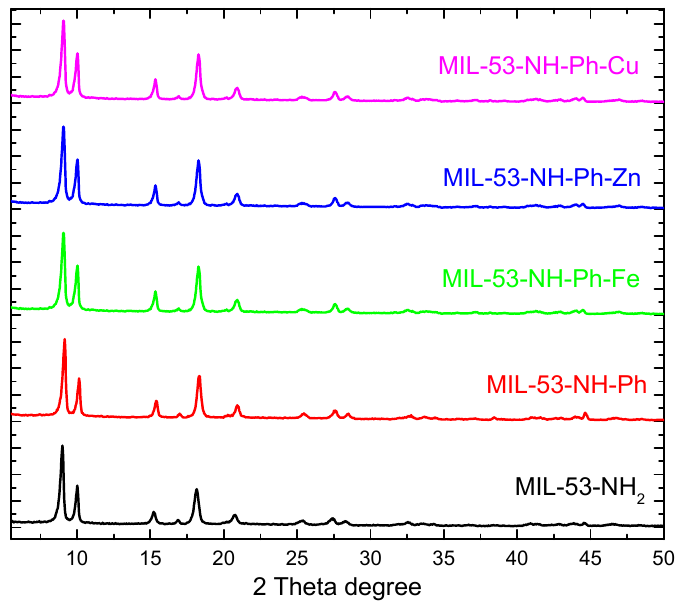
Figure 4. PXRD patterns of MIL − 53 − NH 2, MIL − 53 − NH − Ph, MIL − 53 − NH − Ph − Fe, MIL − 53 − NH − Ph − Zn, and MIL − 53 − NH − Ph − Cu.